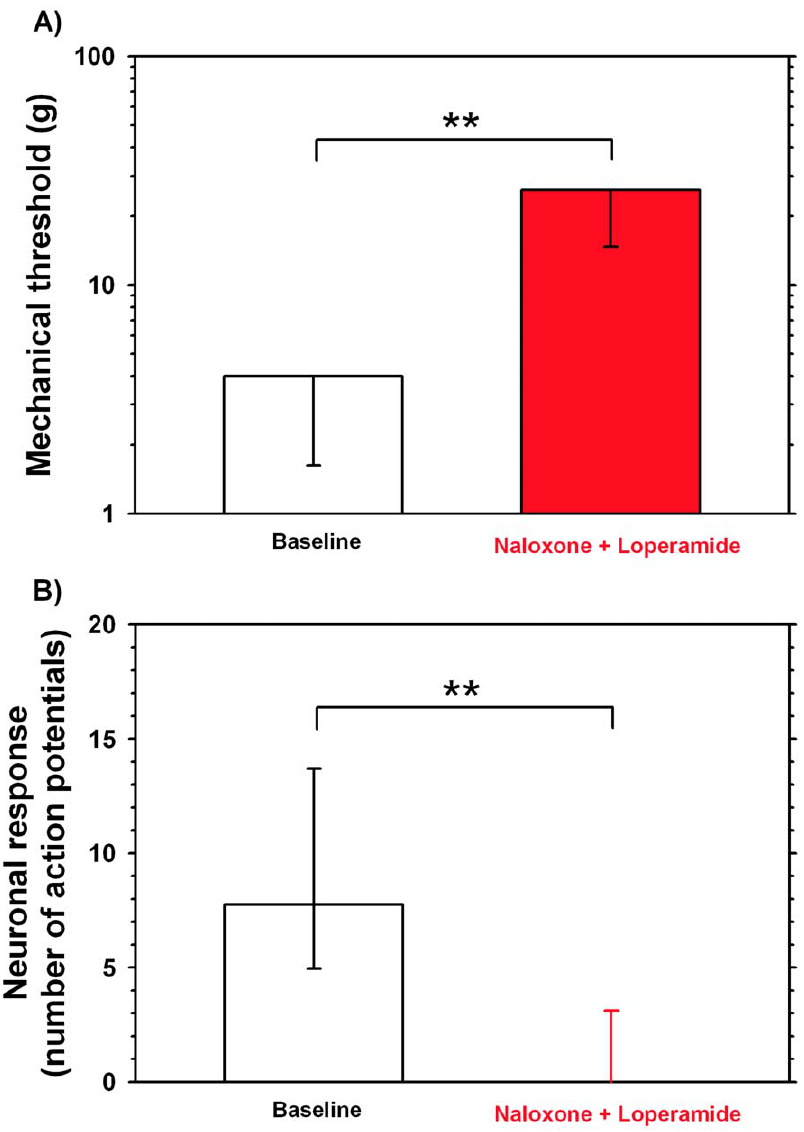
Figure 3. Naloxone does not block loperamide effects on mechanosensitivity of C-fibers. A) Naloxone pretreatment does not prevent the loperamide (5 m g/10 m l) – induced increase in mechanical thresholds of C-fibers. Naloxone was used either in a small (4 m g in 10 m l, n=3) or a high dose (80 m g in 20 m l, n=10). Medians and 25th percentile data are shown. 75th percentiles were identical to median value. (**p , 0.01, Wilcoxon matched pairs, n=13). B) Loperamide –induced decrease in response to suprathreshold mechanical stimulation, is not prevented by naloxone pretreatment. Loperamide and naloxone doses are identical to those used in A. Medians, 25th percentile and 75th percentiles are shown. (**p , 0.01, Wilcoxon matched